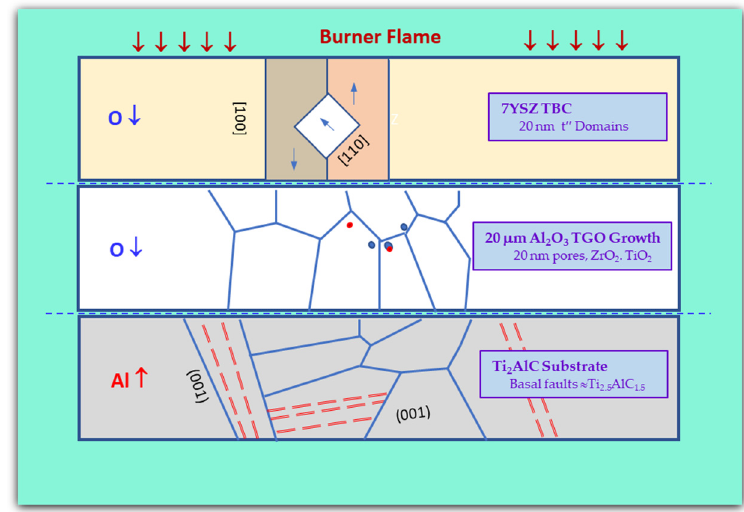
Figure 16. Schematic of substructural features revealed by FIB/STEM for a novel YSZ/Ti 2 AlC system after aggressive oxidation in a burner test, flame direction, arrows (not to scale). Ferro-elastic t” tetragonal domains in the TBC; adherent, inward growing, columnar α -Al 2 O 3 grains, with only minor nm pores or particle defects, red/blue spots; and the Ti 2 AlC MAX phase substrate, with Al-poor stacking faults, red dashes, but no Al depletion